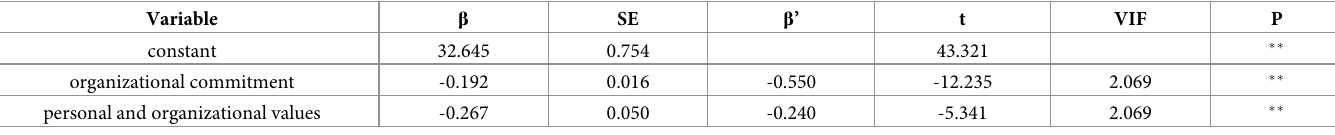
Table 3. The results of multivariable linear regression to predict variables related to turnover intention.